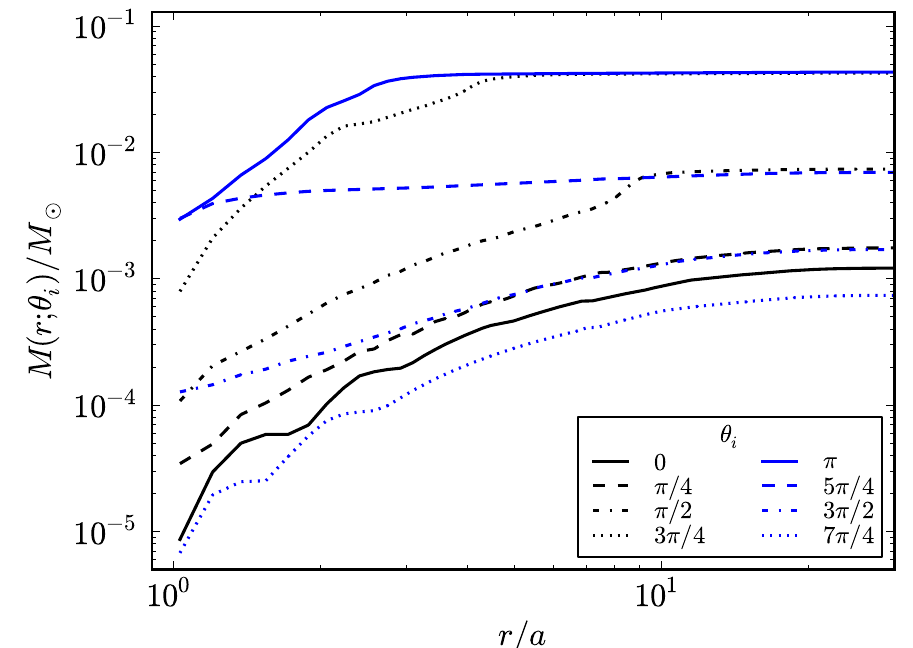
Figure 11. Cumulative radial mass profiles of the SN ejecta enclosed within a cone of 5 ◦ of semi-aperture angle with vertex at the BH position (taken from Figure 35 in [40]). These profiles have been extracted from the simulations at the time of BH formation. The binary parameters are: the initial mass of the NS companion is 2.0 M ; the CO core leading to an ejecta mass of 7.94 M , and the orbital period is (cid:12) (cid:12) P 5 min, namely a binary separation a 1.5 10 10 ≈ ≈ ×